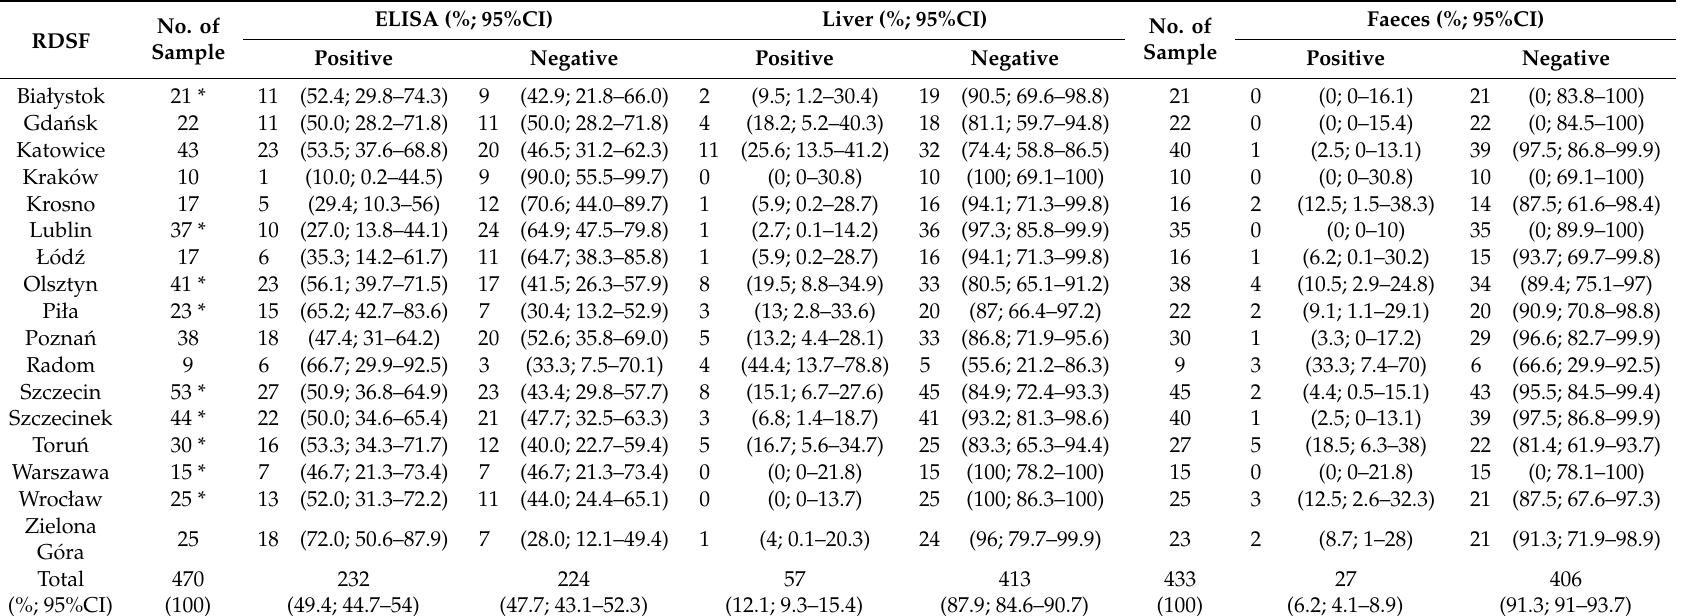
Table 2. Results of serological and molecular testing of wild